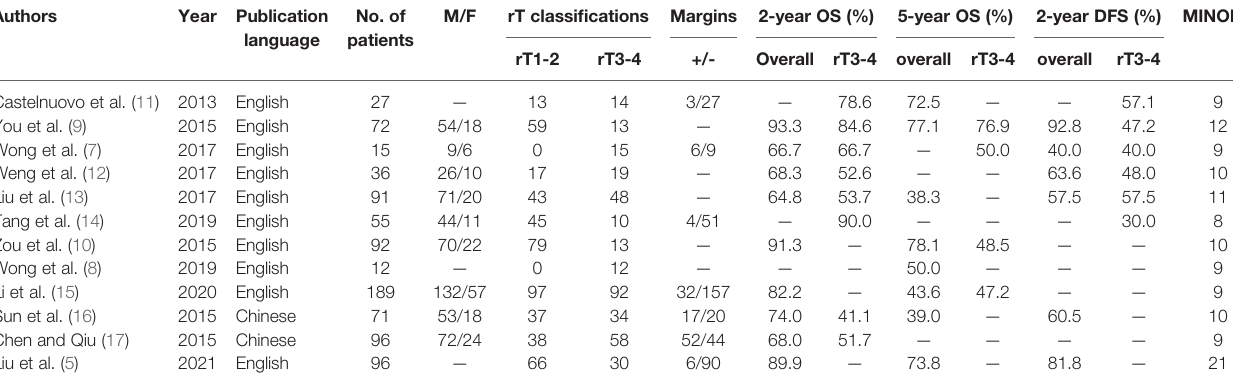
TABLE 1 | Main characteristics of included studies on endoscopic